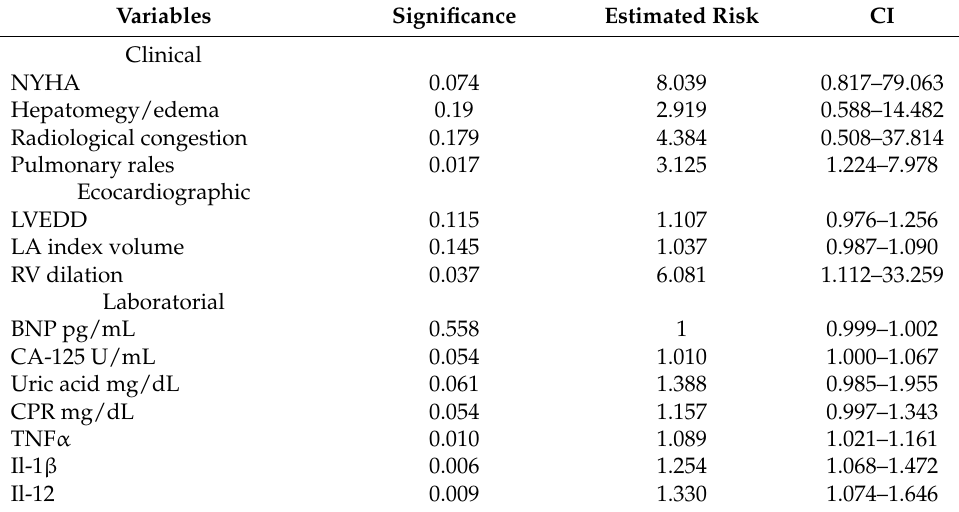
Table 4. Univariate Cox regression model.